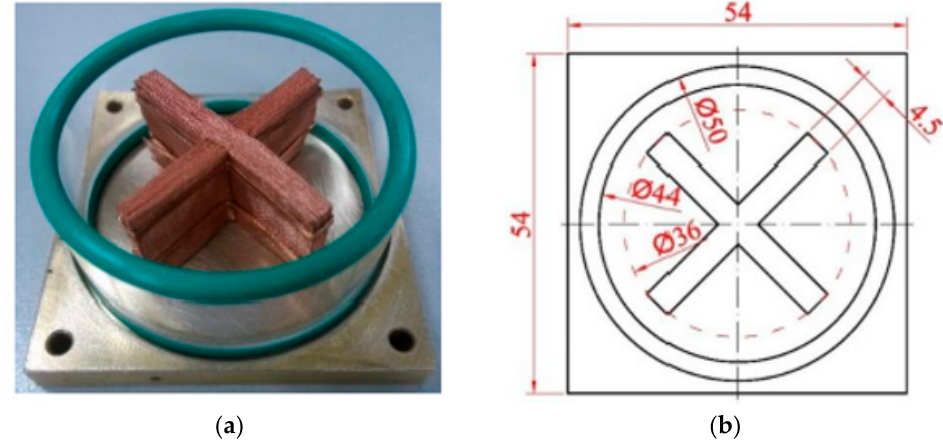
Figure 4. Structure of the cross-shaped wick: ( a ) picture of cross-shaped wick; ( b ) dimensions of cross-shaped wick.